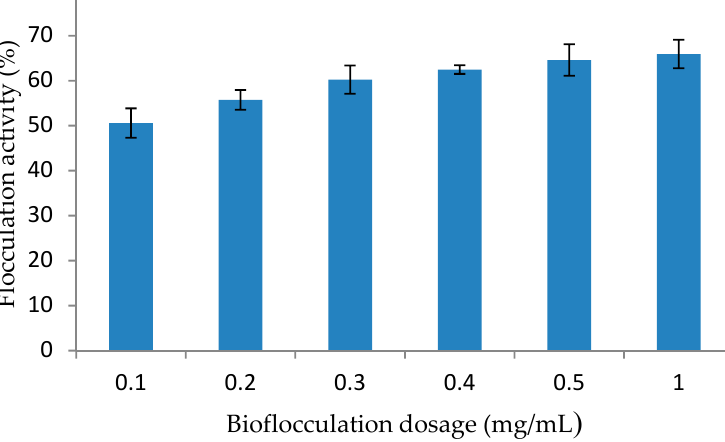
Figure 3. Effect of Bioflocculant Dosage on Flocculating Activity of the Purified Bioflocculant.